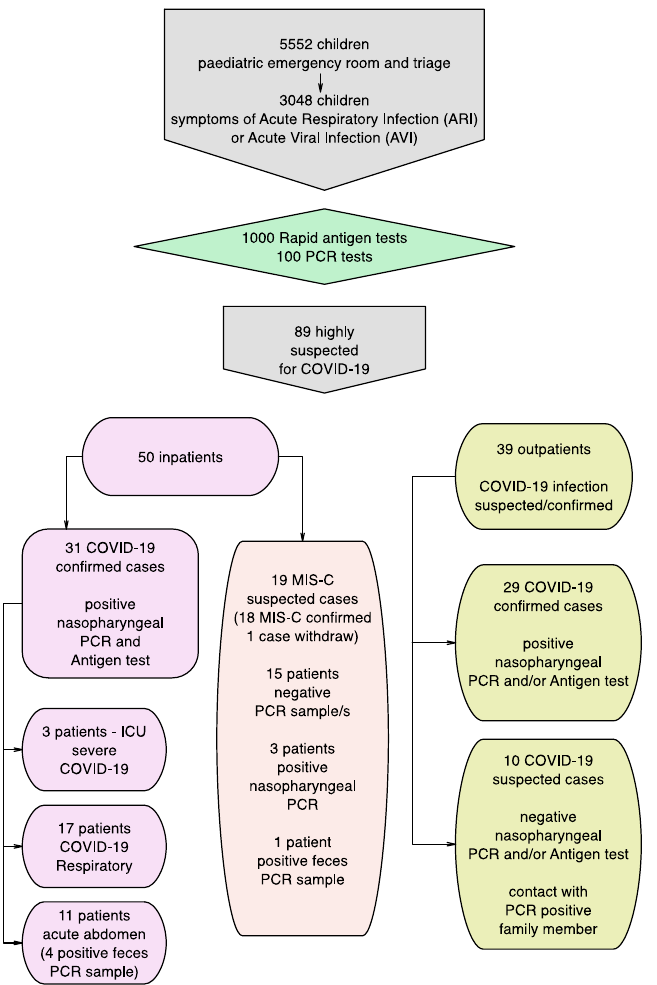
Figure 1. Study design—patient flows, groups and sub-groups. Nineteen children ( n = 19) presented with symptoms meeting the criteria for MIS-C.